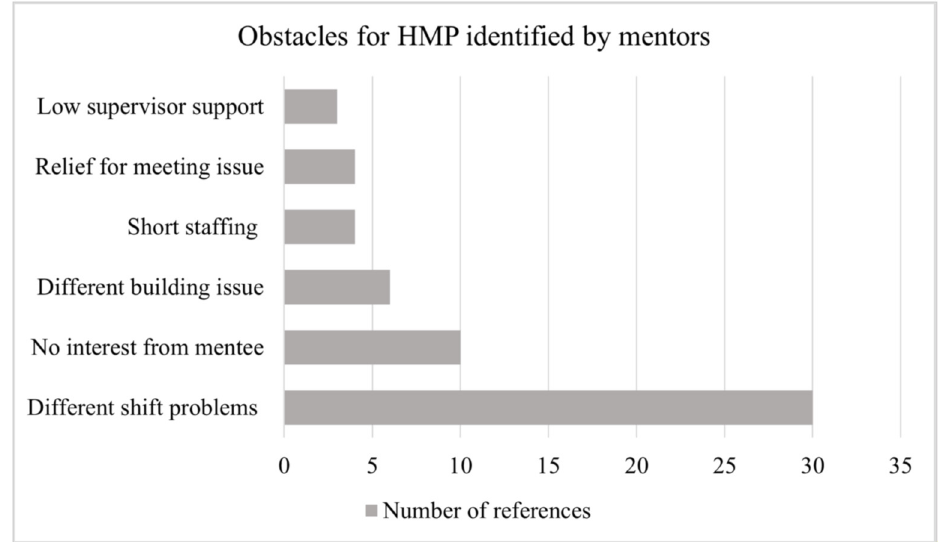
Figure 1. Obstacles for HMP.